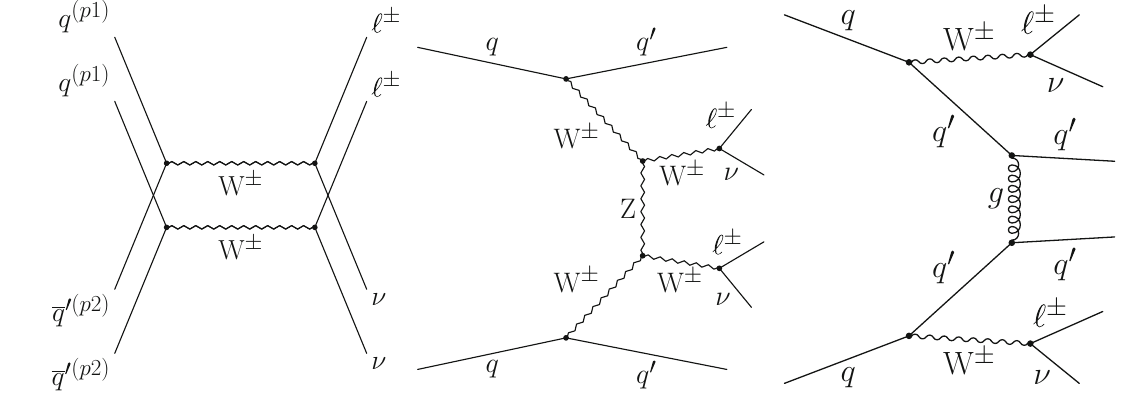
Fig. 1 Schematic diagrams corresponding to the production of W ± W ± via the DPS process (left) and via SHS processes (middle and right),